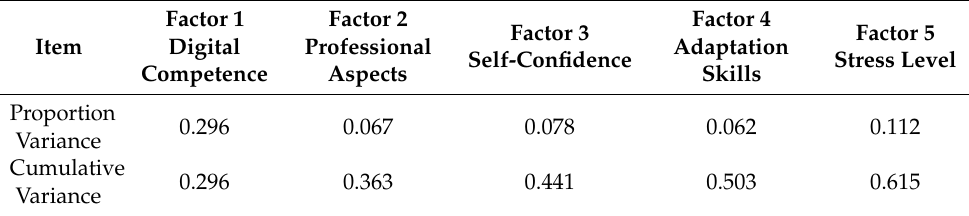
Table 4. Cumulative proportion of explained variance of the principal component